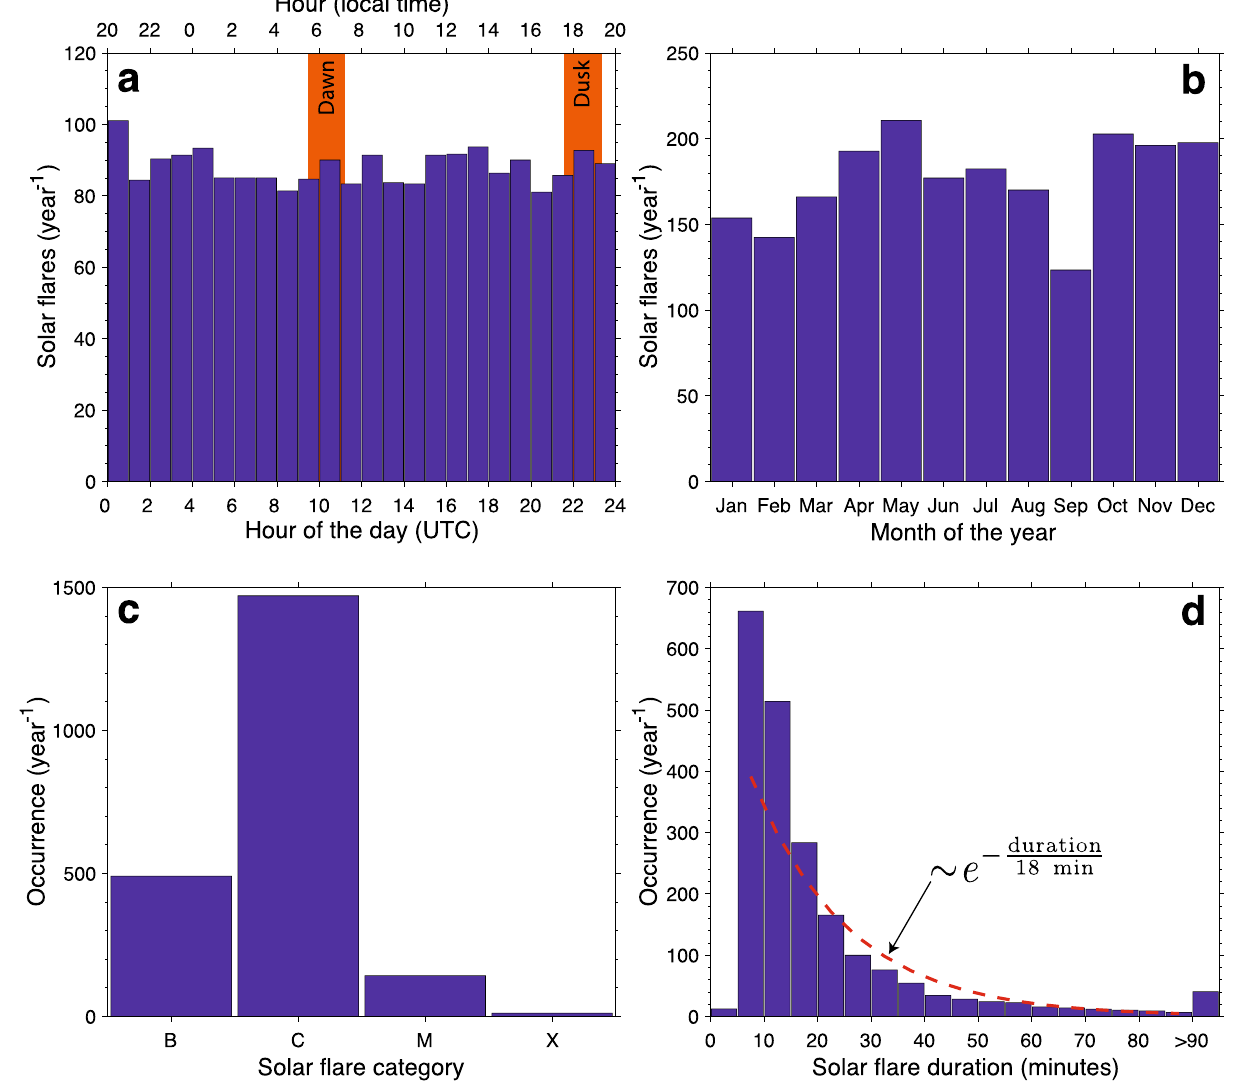
Figure 2. Solar flare occurrence rate in 2012–2014. Histograms of solar flare occurrence per year binned according to: ( a ) hour of the day, ( b ) month of the year, ( c ) category, and ( d )